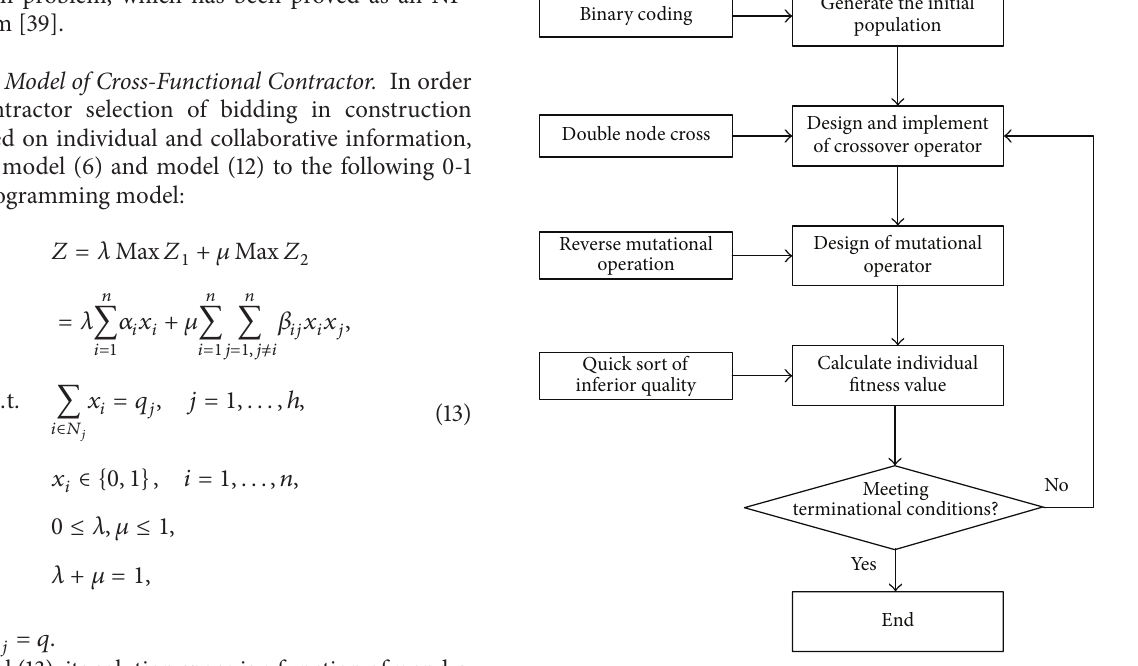
Figure 4: Algorithm process for units selection model of the